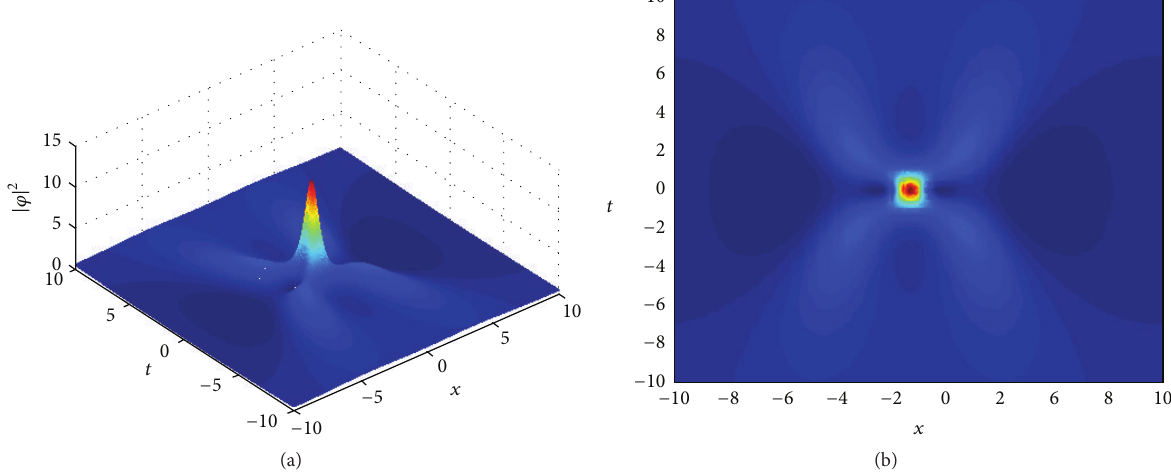
Figure 6: (a) The second-order rogue wave propagations for the intensity |𝜑| 2 . (b) Contour plot with the gravity field 𝑏 = 0.5 , 𝛽(𝑡) = 0.2